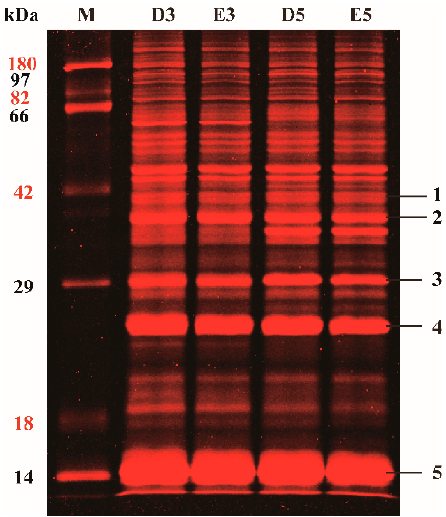
Figure 1. Profiles of glycosylated proteins from the rubber latex in 1-DE gel. Total proteins were extracted from the rubber latex after treating with water and ethylene for three (D3; E3) and five (D5; E5) days, and then the glycosylated protein bands were visualized by Pro-Q Emerald 488 stain. The main bands in the gels were exposed to MALDI TO / TOF MS and five main protein bands were positively identified from these bands. M, protein